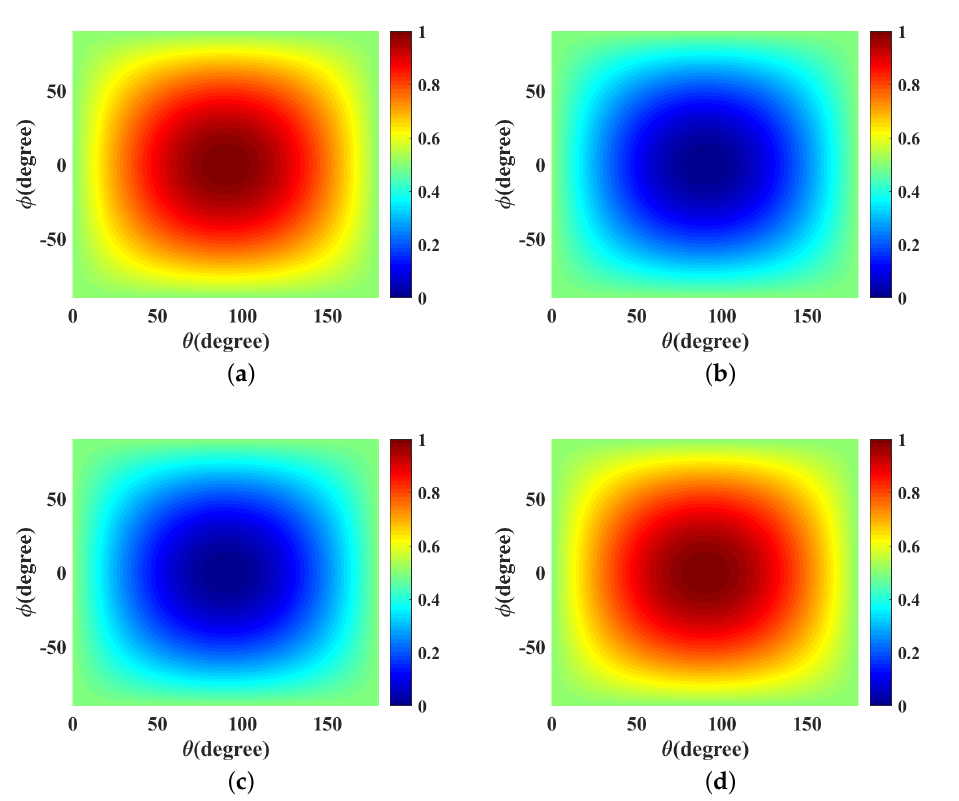
Figure 3. Copolar and cross-polar electric fields for LHCP and RHCP dipoles. ( a ) co-polarization pattern of LHCP dipoles; ( b ) cross-polarization pattern of RHCP dipoles; ( c ) cross-polarization pattern of LHCP dipoles; ( d ) co-polarization pattern of RHCP